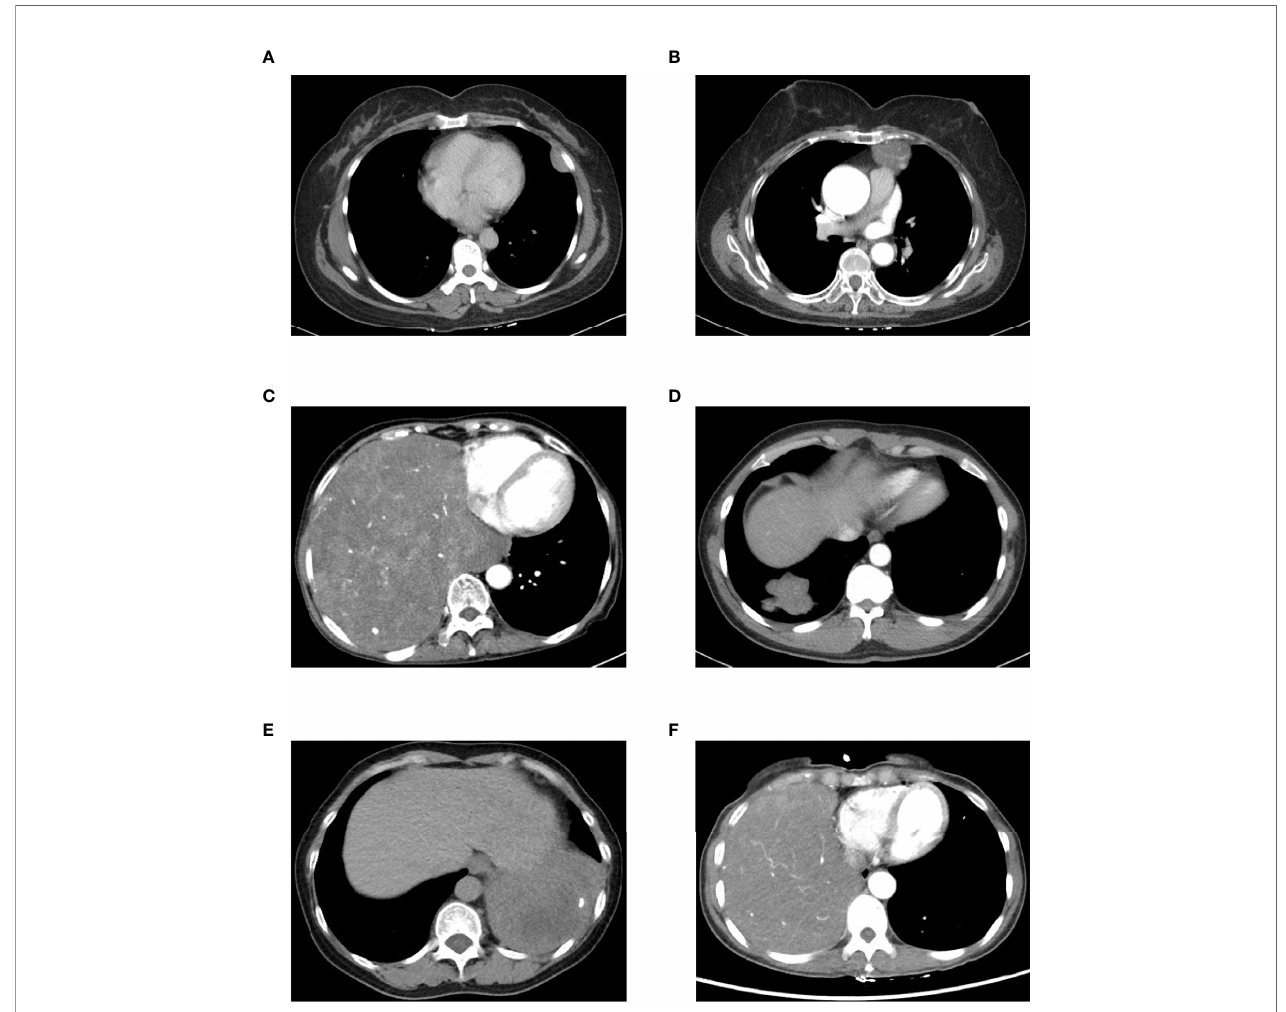
FIGURE 1 | CT features of the 50 SFTC patients: (A) a mound-like lesion with uniform internal density in the left pleura; (B) a circular lesion in the left mediastinum with vascular shadows inside; (C) a huge lesion in the right thoracic cavity with uneven internal density, showing uneven enhancement; (D) a lobular lesion in the right lung with burr signs; (E) a lesion with calci fi cation and necrosis in the left thoracic cavity; and (F) a lesion with multiple tortuous vascular shadows in the right thoracic